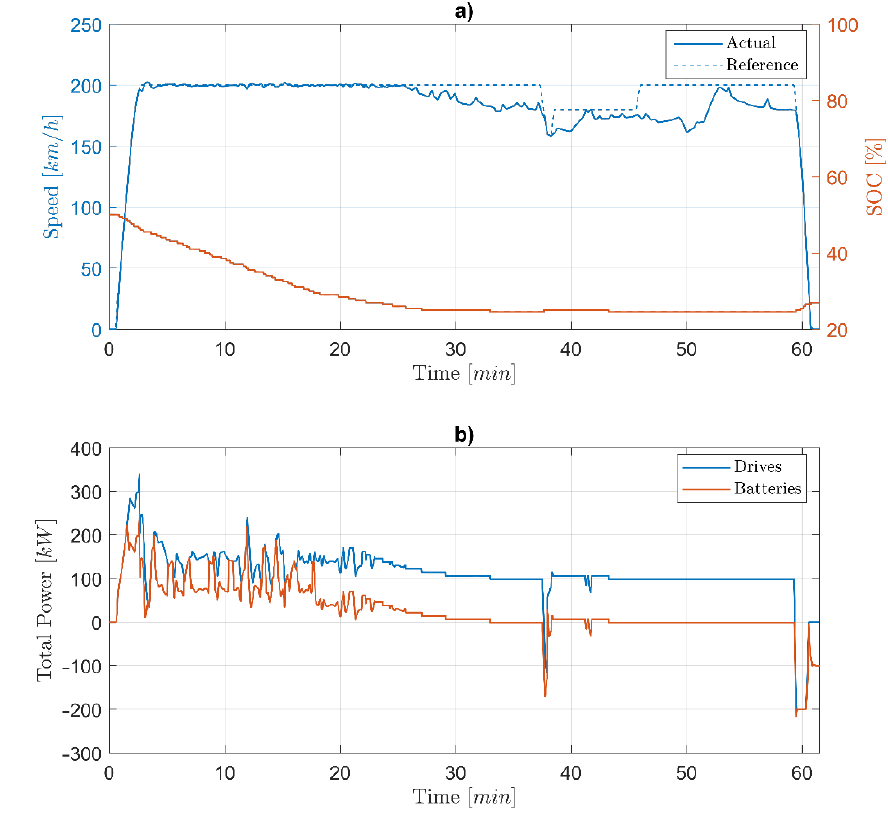
Figure 13. Simulation results of the second scenario in terms of the speed of the vehicle and SOC ( a ) and total power of the motor drives and total power of the batteries ( b ). ( a ) and total power of the motor drives and total power of the batteries ( b